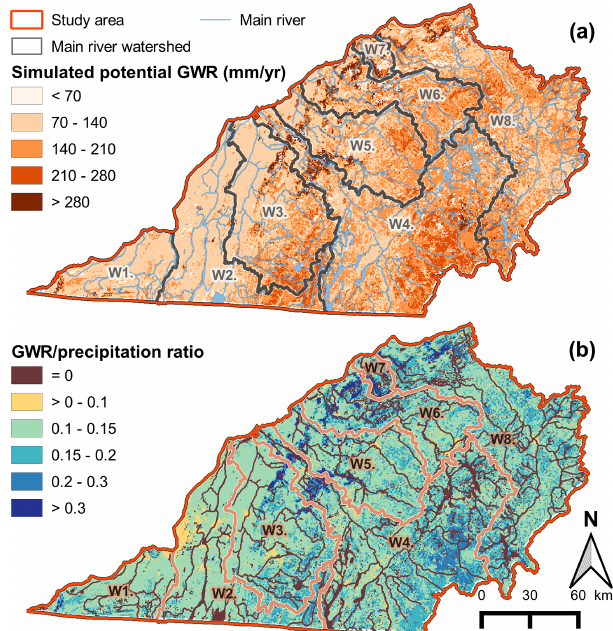
Figure 6. (a) Average potential GWR simulated using the Hy- droBudget model for the study area between 1961 and 2017 and (b) GWR/precipitation ratio for the same